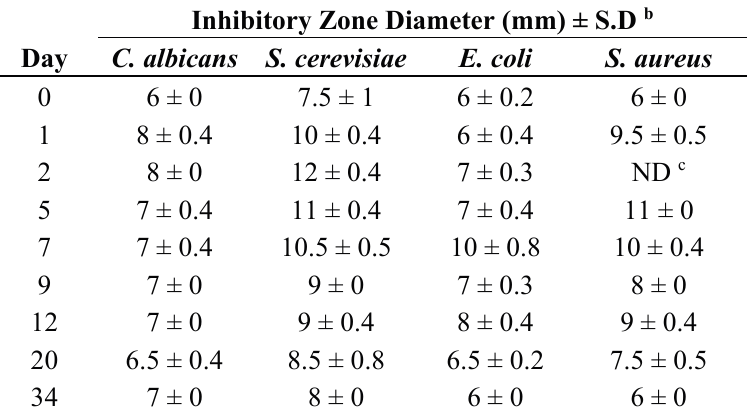
Table 1. Inhibitory zones as determined during the autoxidation process of ML a .